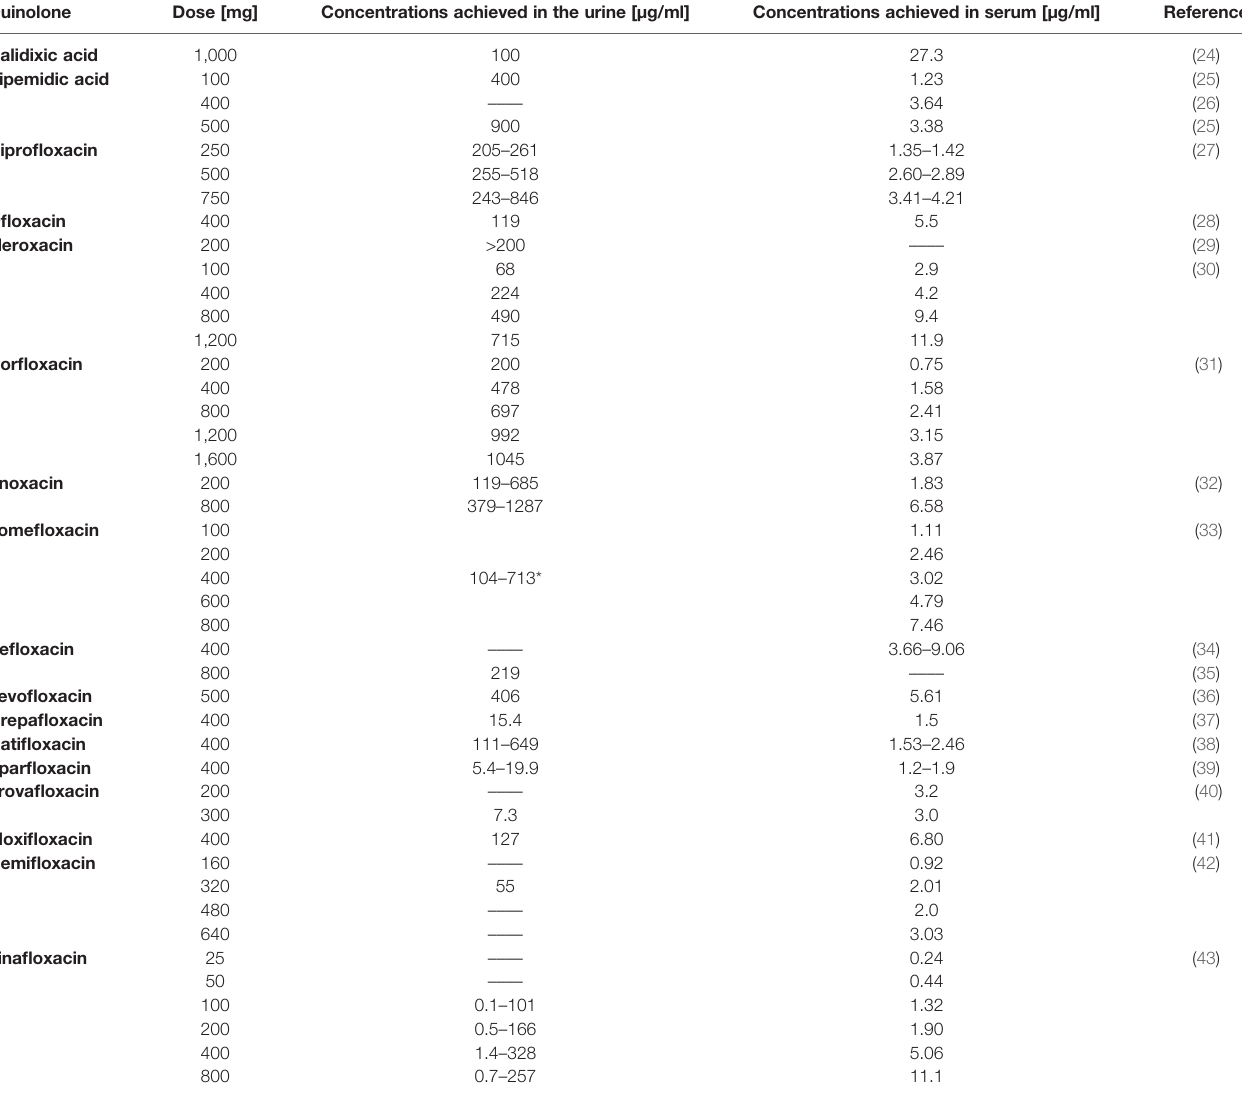
TABLE 1 | Concentrations achieved in urine and serum after a speci fi c dose application for individual quinolones. Quinolone Dose [mg] Concentrations achieved in the urine [µg/ml] Concentrations achieved in serum